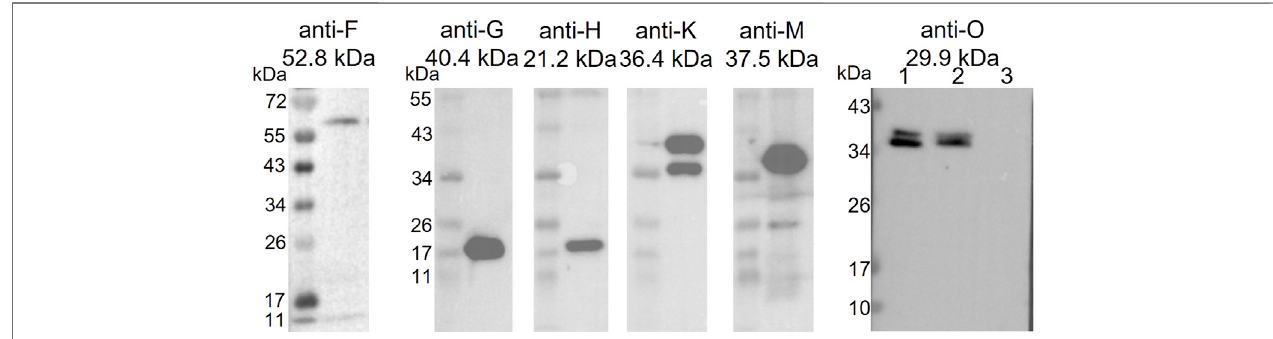
FIGURE 6 | Western Blot of the elution fractions of the pull-down with TraB-Strep. The used anti-Tra antibody and the MW of the respective Tra pIP501 protein is given above the blot. The TraG protein runs signi fi cantly faster than its calculated MW. One possible explanation would be that only the CHAP domain of TraG is part of the eluted protein complex. The two TraK bands correspond to its two start codons resulting in proteins of sizes of 36.4 and 32.3 kDa. The Western Blot with anti-TraO antibodywasperformedasnegativecontrol.TraOispresentinthelysate(lane1)andinthe fl owthroughofthecolumn(lane2),butnotintheelutionfraction(lane3). ThetwobandsareshowingTraOwithandwithoutitssecretionsequence(thedifferenceinMW=2.5 kDa).TheslowermigrationoftheTraObandsmaybeexplainedby the high acidity of the proteins (pI 3.8 and 3.7) (Matagne et al.,